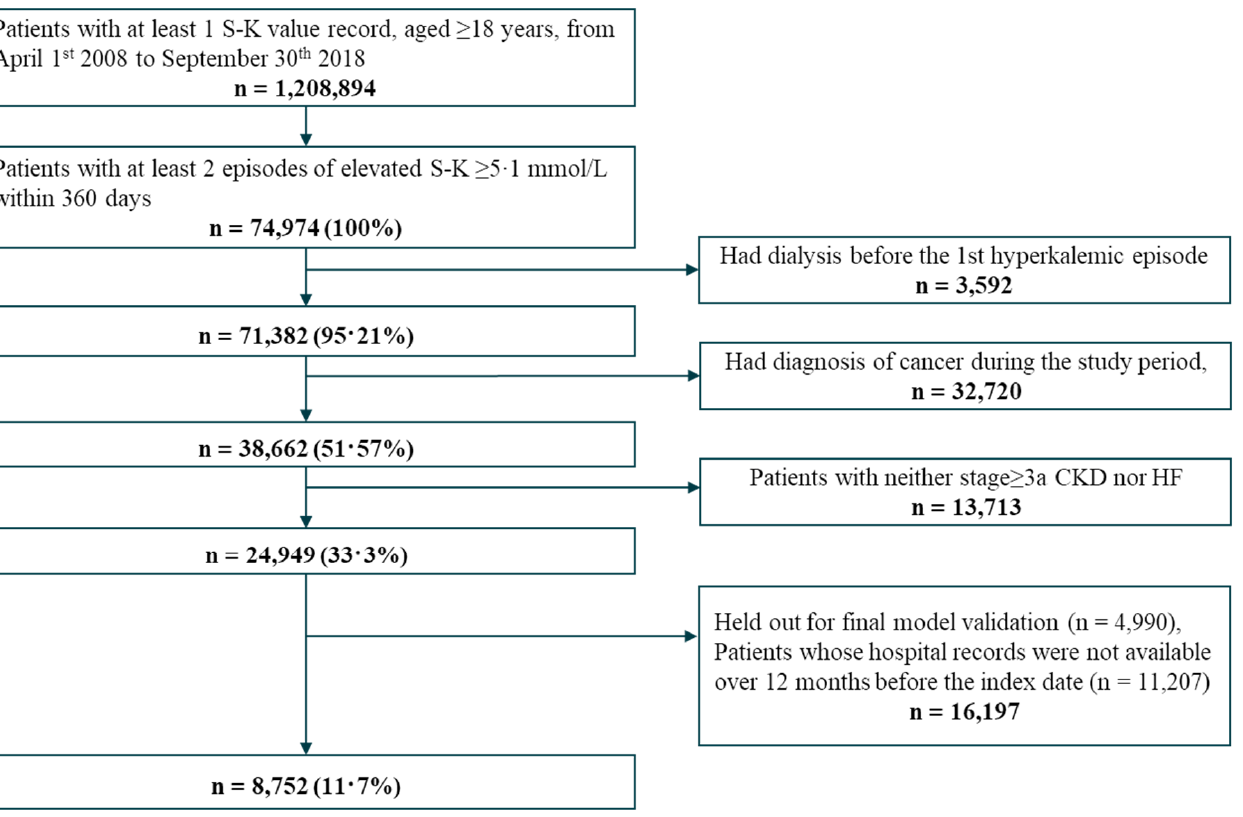
Figure 1. Patient flow diagram for model development.